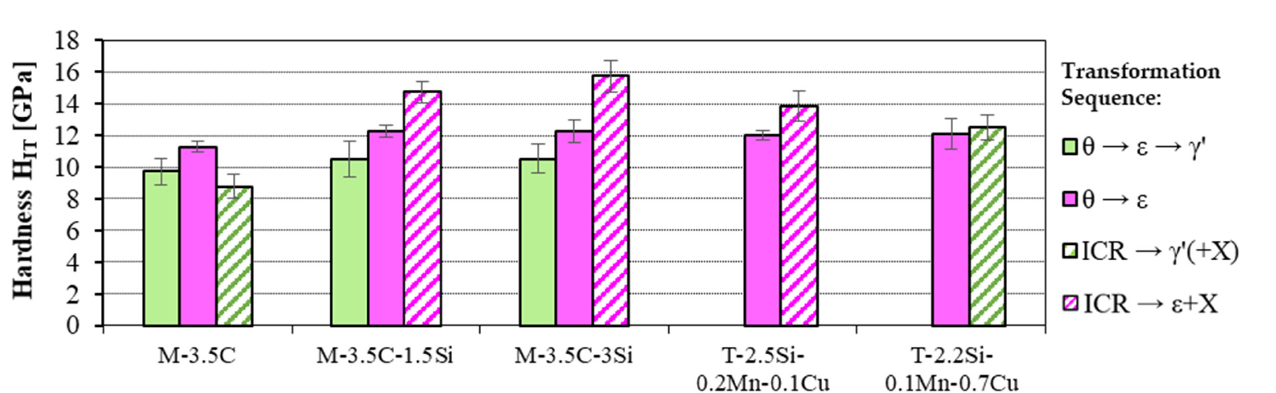
Figure 10. Influence of Si content and local initial microstructure (eutectic cementite θ and intercar- bidic, ferritic-pearlitic regions in the ICR) on the hardness of the ε and γ ’ phases formed from eutectic cementite, as well as of the γ ’ phase (only M-3.5C) and of the ε + X and γ ’ + X phase mixtures formed in the ICRs after nitriding (540 ◦ C, 16 h, K N = 1 atm − 1/2 ); hardness measurement with F max = 10 mN. For the commercially available cast iron alloys, the areas near the surface with eutectic cementite that transformed into γ ’ (transformation sequence θ → ε → γ ’) were too small for hardness measurements.